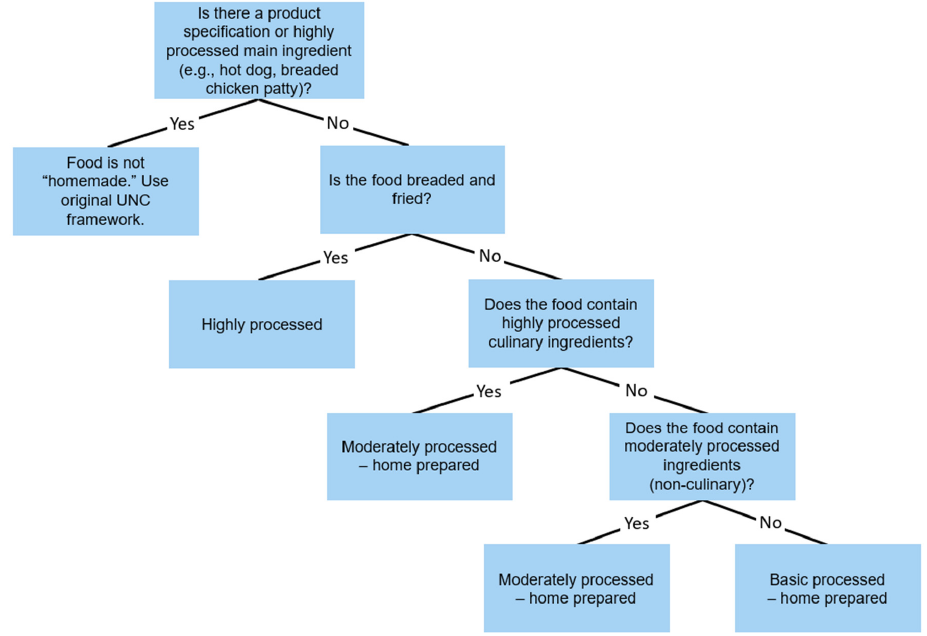
Figure 1. Decision tree for the home-prepared (HP) classification framework, adapted from the University of North Carolina (UNC) at Chapel Hill system [13] to include a designation between home-prepared and industrially produced foods.